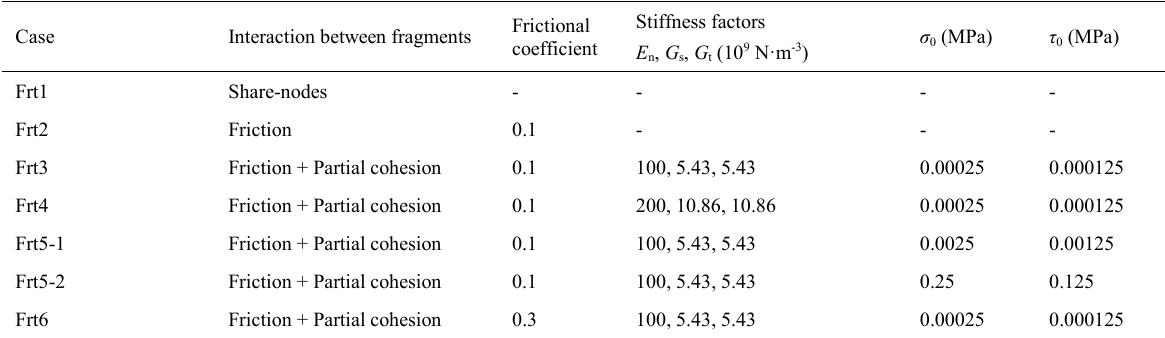
Table 2: Interaction property between glass fragments.